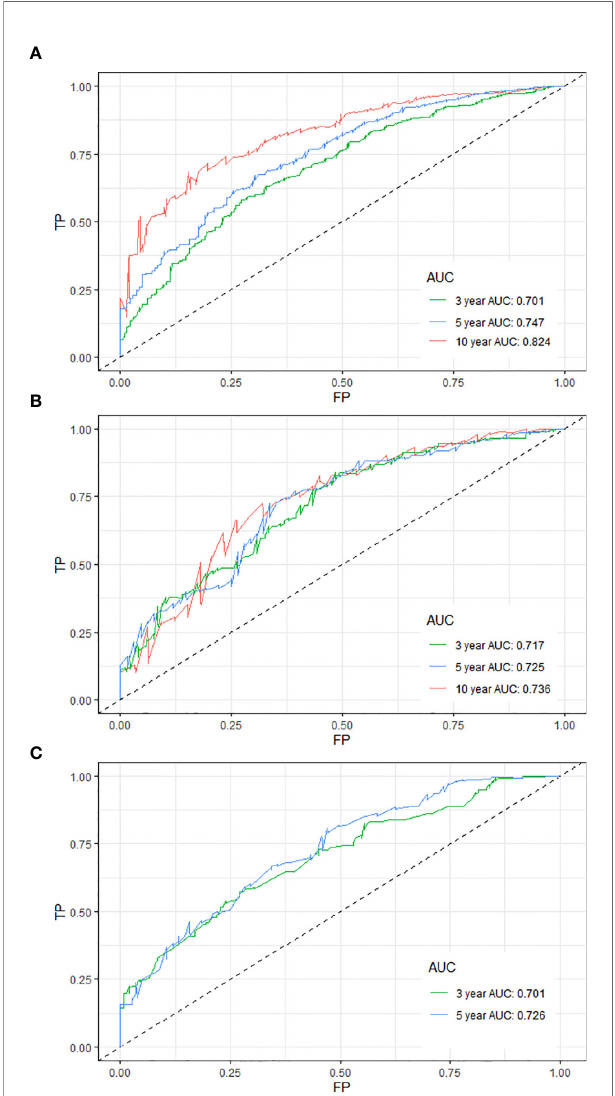
FIGURE 2 | Time-dependent receiver operating characteristic curves for predicting the 3-, 5-, and 10-year OS of PPSC patients in the training (A) , internal validation (B) , and external validation (C)